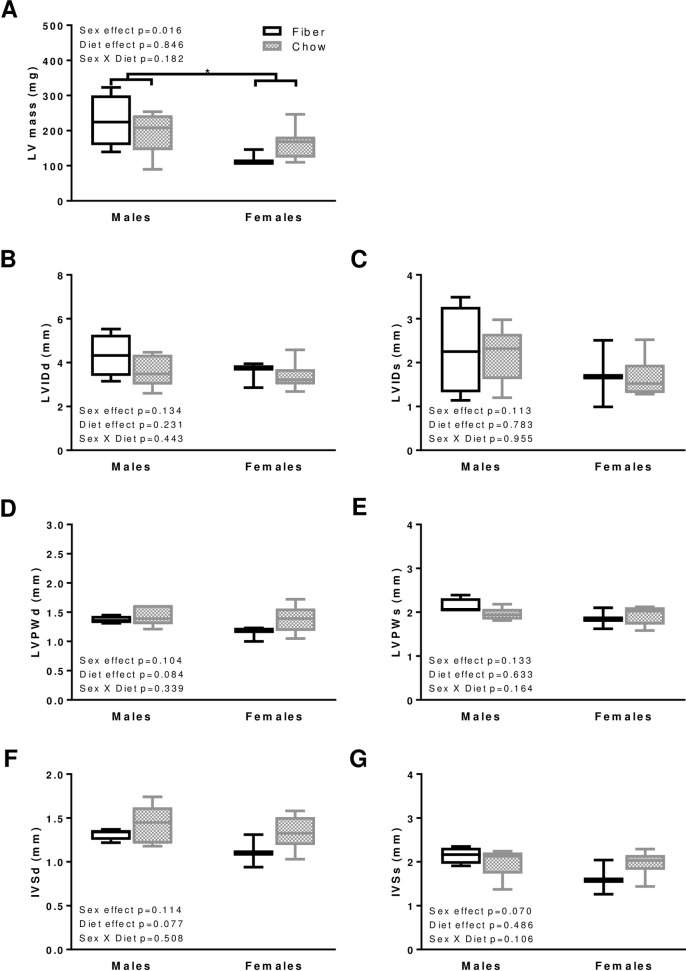
Morphology in males and females from the Fiber (black boxes) and Chow (grey boxes) groups.The following parameters were measured: left ventricular (LV) mass (A), left ventricular internal diameter (LVID, B and C), left ventricular posterior wall thickness (LVPW, D and E), interventricular septum wall thickness (IVS, F and G) at end-diastole (d, left panels B, D, F) and end-systole (s, right panels C, E, G). Boxes indicate the minimum, 25th percentile, median, 75th percentile, and maximum. BPM indicates beat per minute. In males, N equals 4 and 5 for Fiber and Chow groups, respectively. In females N equals 3 and 8 in Fiber and Chow groups, respectively. Significant differences between dietary groups or sexes are indicated with * for p<0.05. Kruskal-Wallis results are indicated on each panel.